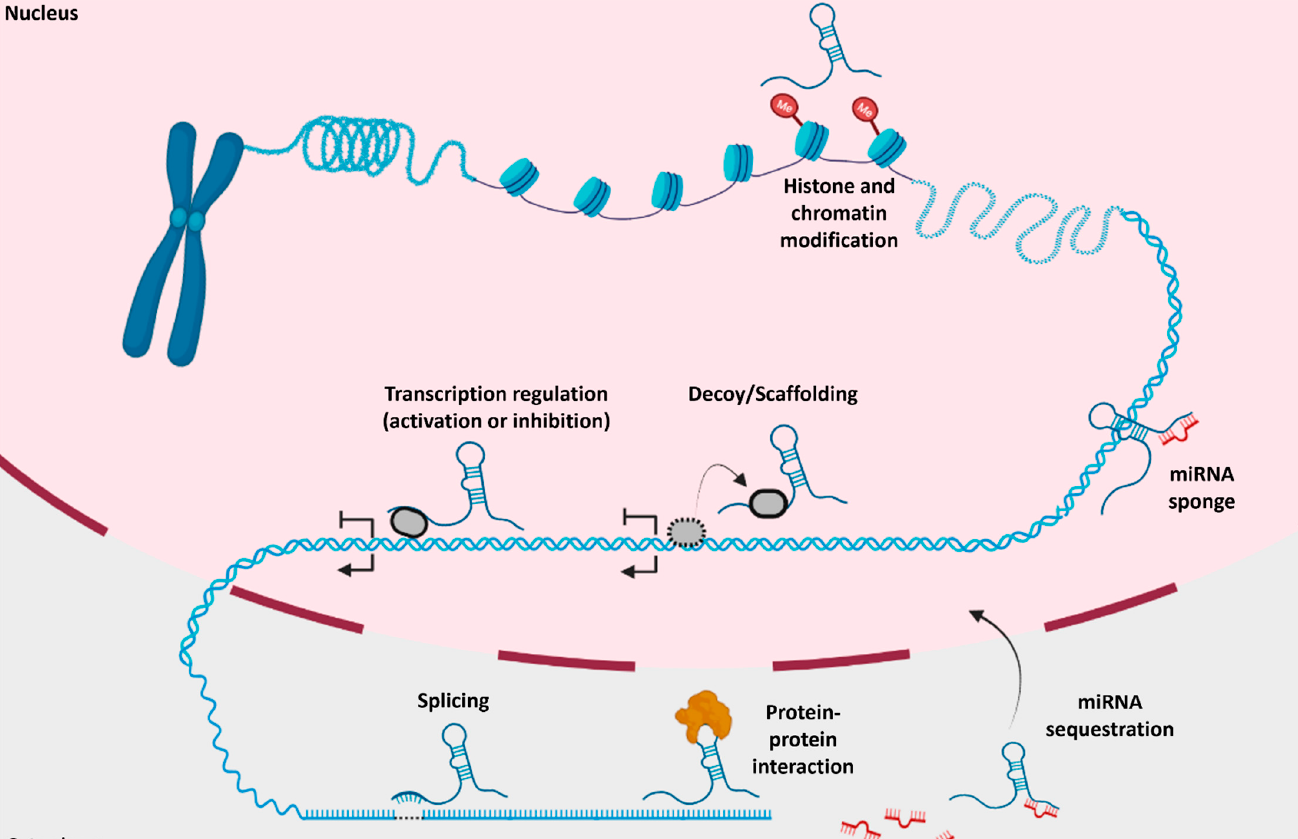
Figure 3. Molecular and pathological mechanisms of lncRNAs in and outside the nucleus: Various functions of lncRNAs occur, such as histone modification, transcriptional regulation, scaffolding, microRNA sequestration, splicing, and protein–protein interaction. Adapted from Hu et al. 2018 and Yang et al. 2021. Created using BioRender.